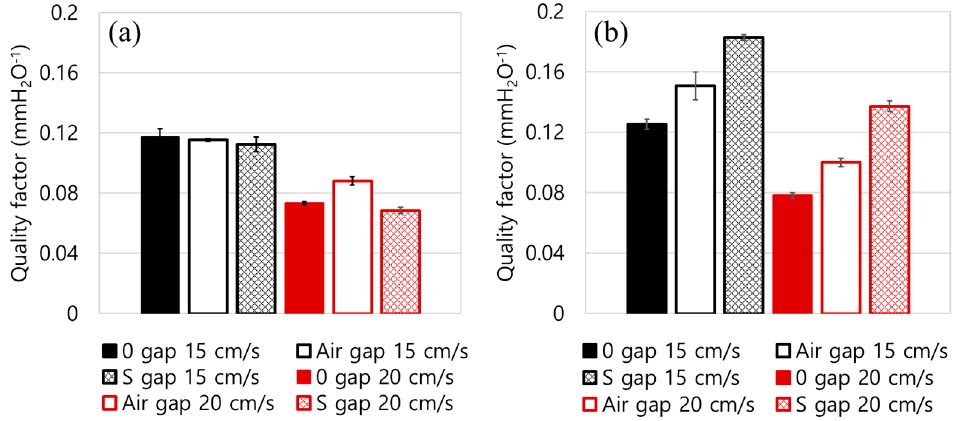
Figure 7. Quality factor at 20 mg NaCl loading. ( a ) Quality factor for 2-layer construction, ( b ) Quality factor for 4-layer construction.